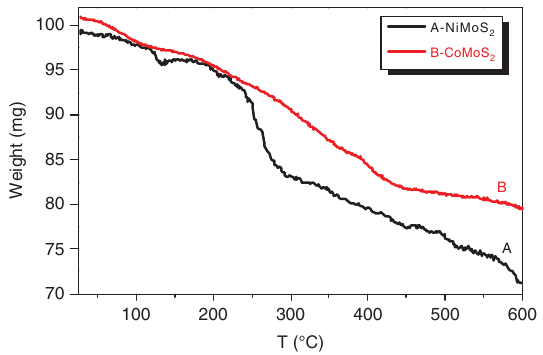
and (B) CoMoS 2 2